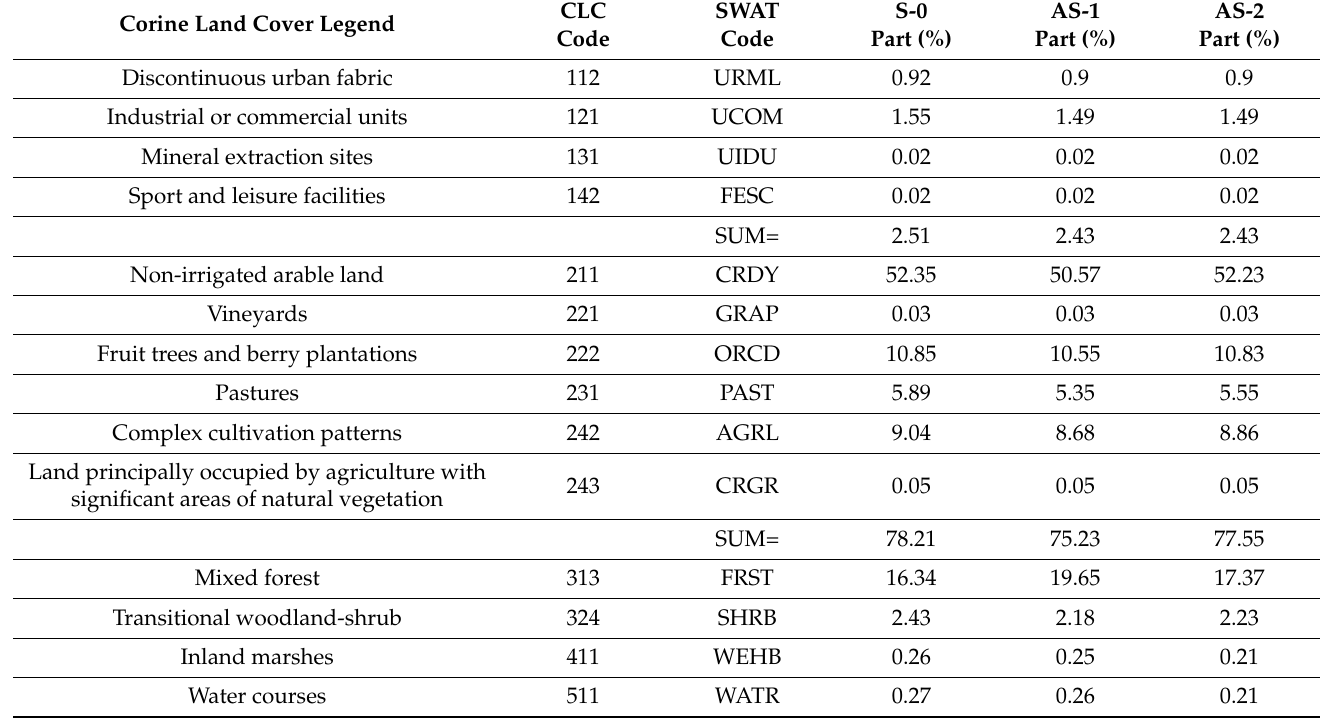
Table 4. Division of the land cover and land use as well as the percentage of land use in the Bystra catchment generated in the QSWAT interface. CLC code 112–142 means artificial surfaces; code 211–243 means agricultural areas; code 313–324 means forest and semi natural areas; code 411 means wetlands, and code 511 is water bodies (own